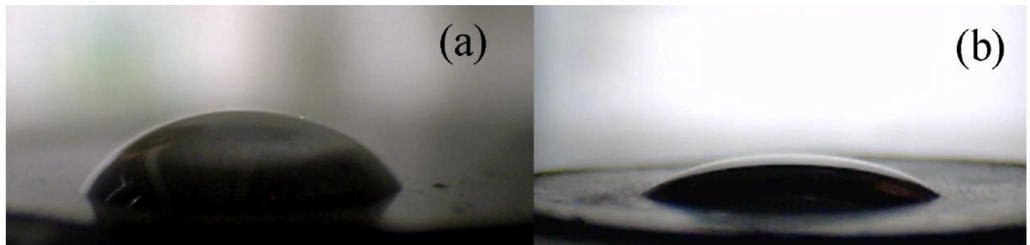
Figure 5. Images from a CCD camera of the 5 µ L poly(dimethylsiloxane) (PDMS) droplets on the neat GO ( a ) and the GO-PHEMATMS ( b